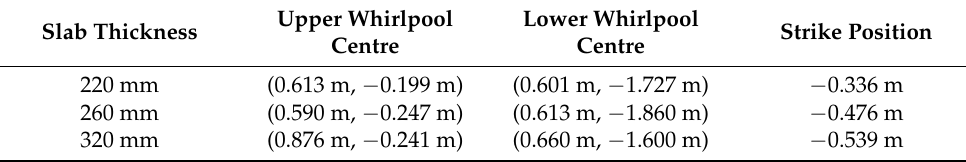
Figure 10. Fluid contours: ( a ) trajectory line; and ( b ) flow field at a thickness of 320 mm. Table 4. Whirlpool core positions and strike locations under different slab